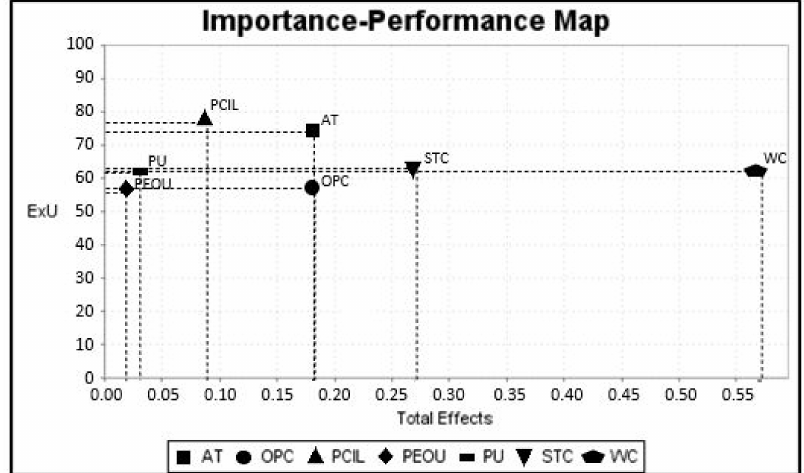
Figure 6. 3 IPMA for the endogenous variable extended use of the ERP system